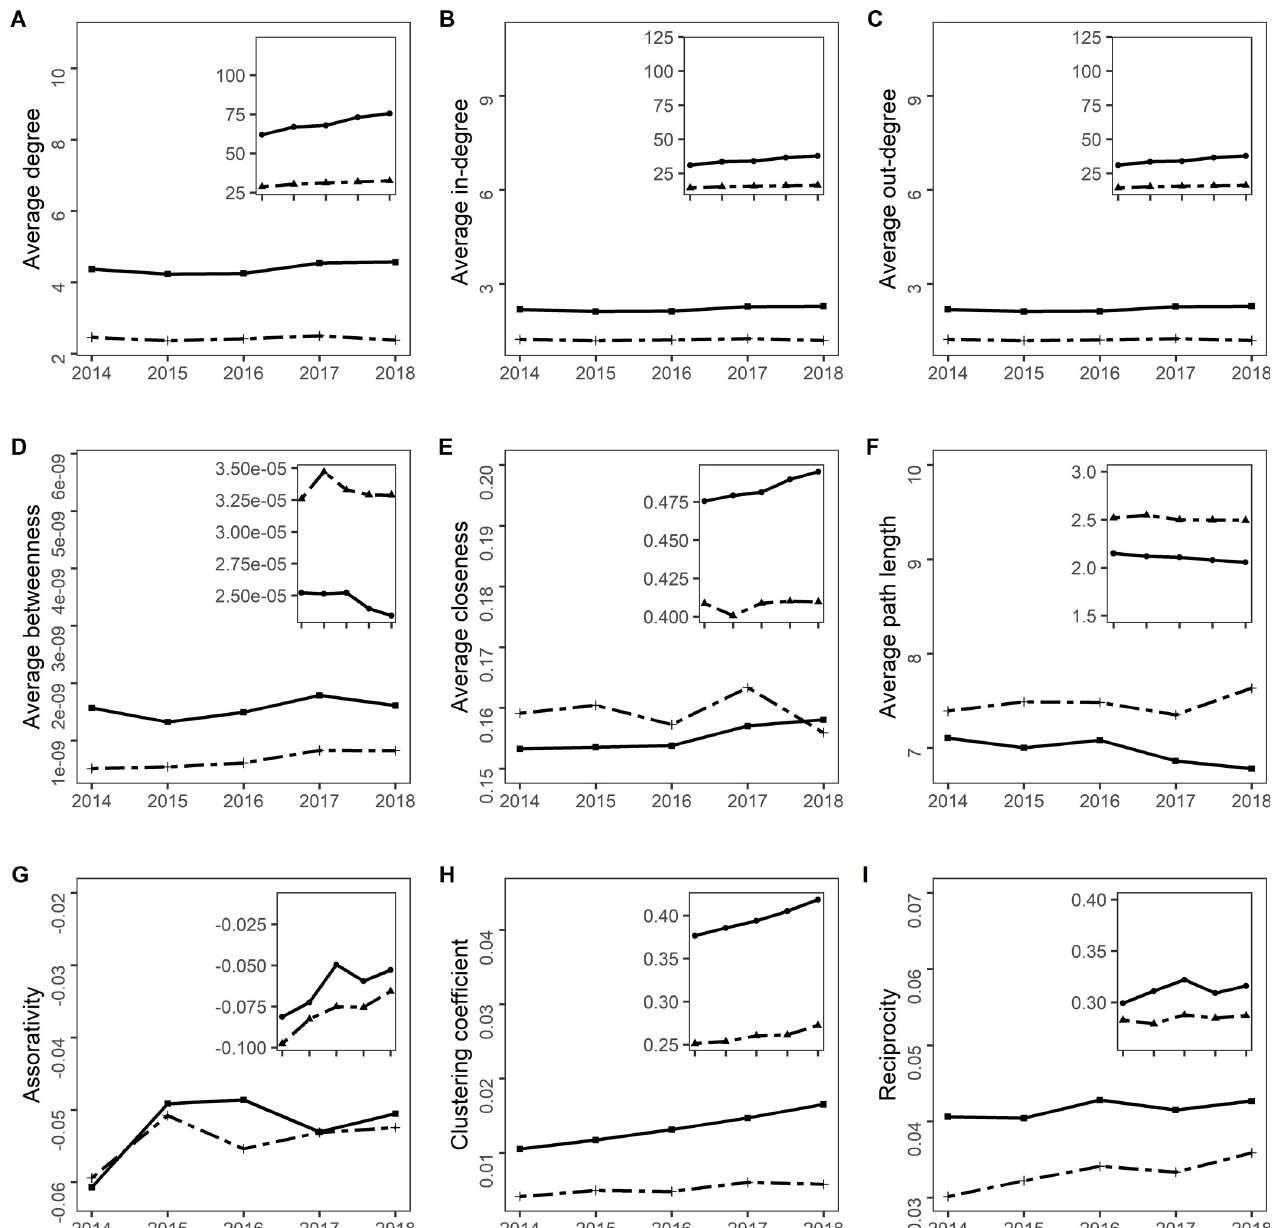
Fig 7. Network indicators for the annual networks for all cattle and only cows in Paraguay. Holding level (main graphs), district level (insets), all cattle (plain line) and only cows (dashed line). path length: 5.53) than in the only cow global network (average path length: 7.18) (Table 4) . The diameter at the holding level was 20 for all cattle and 26 for only cows (Table 4) . Assorta- tivity was negative for all the networks at the holding level, indicating that nodes were more frequently linked to nodes with a different degree. Clustering coefficient values were lower for the networks at the holding level. The low reciprocity values obtained for all networks, mainly at the holding level, indicated that very few holdings received cattle from holdings to which they sent animals. (Fig 7) . For the annual networks, densities ranged from 4.86.10 − 05 to